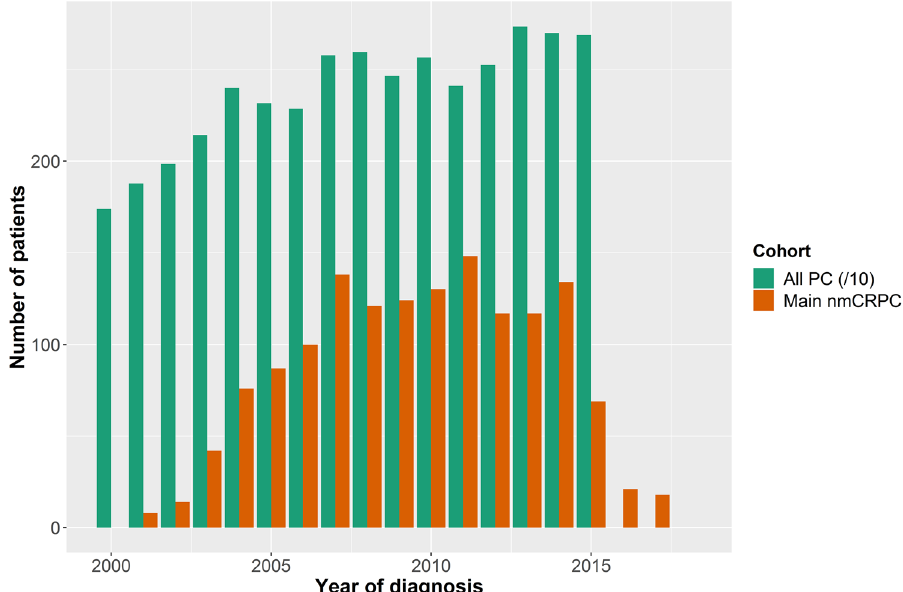
Figure 1. Incidence of PC and nmCRPC (for individuals diagnosed with PC from 2000–2015). Incidence of PC is defined as the number of patients with a first PC diagnosis in each year. Incidence of nmCRPC is the number of patients with a PC diagnosis who have received ADT and who have ≥ 3 PSA tests which indicate nmCRPC. The date of nmCRPC incidence is the first test showing an increase in PSA, i.e. the second test overall. The third PSA test confirms the increase. Incidence of PC has been divided by 10 to allow for easy comparison with the incidence of nmCRPC. ADT: androgen depravation therapy; nmCRPC: non-metastatic castration-resistant prostate cancer; PC: prostate cancer; PSA: prostate-specific antigen.